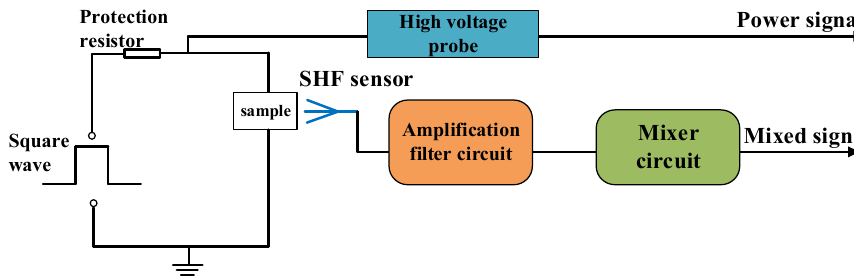
Figure 15. SHF partial discharge test system diagram.